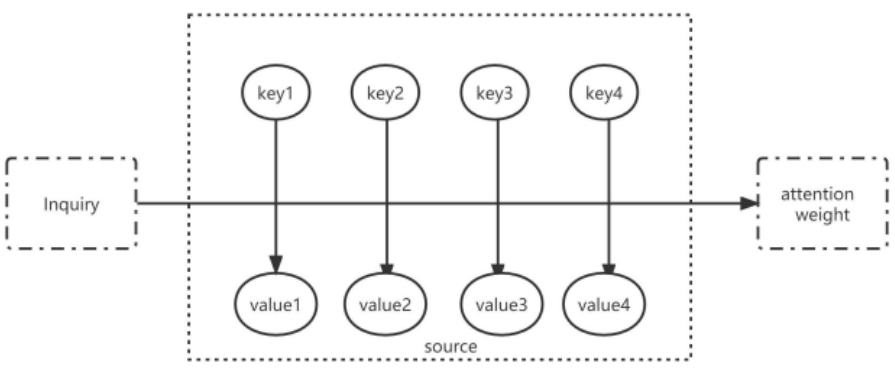
Figure 2. Calculation flow of attention